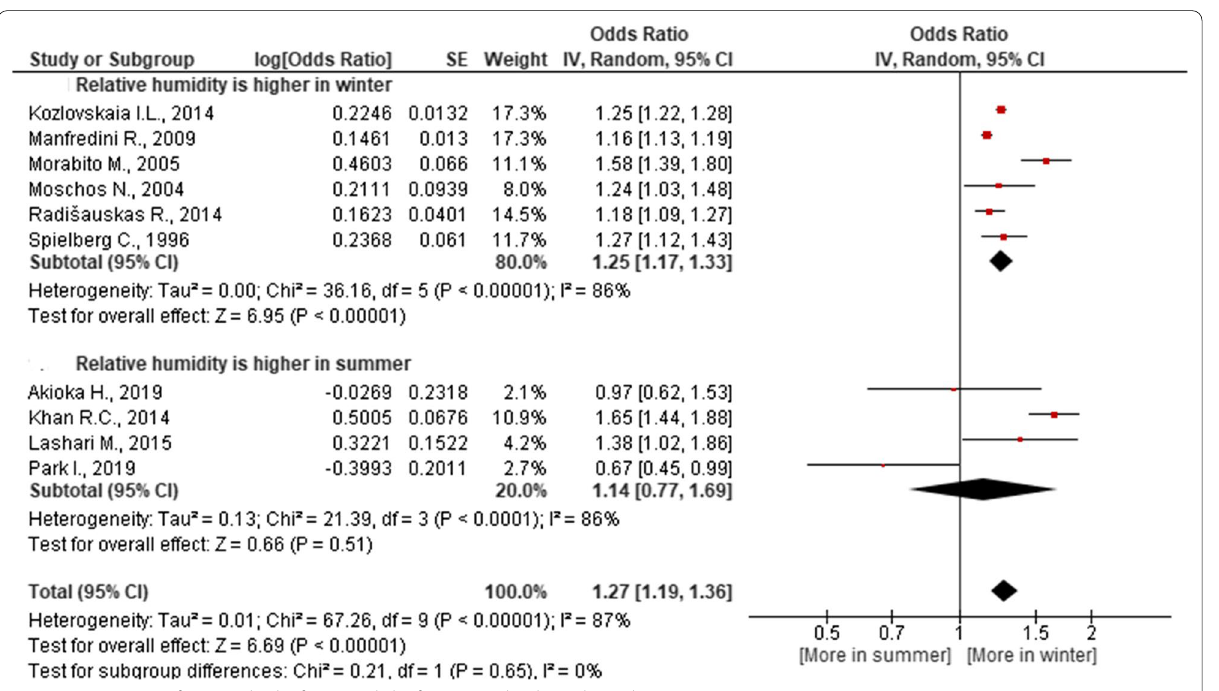
Fig. 4 Association of seasonal risk of myocardial infarction with relative